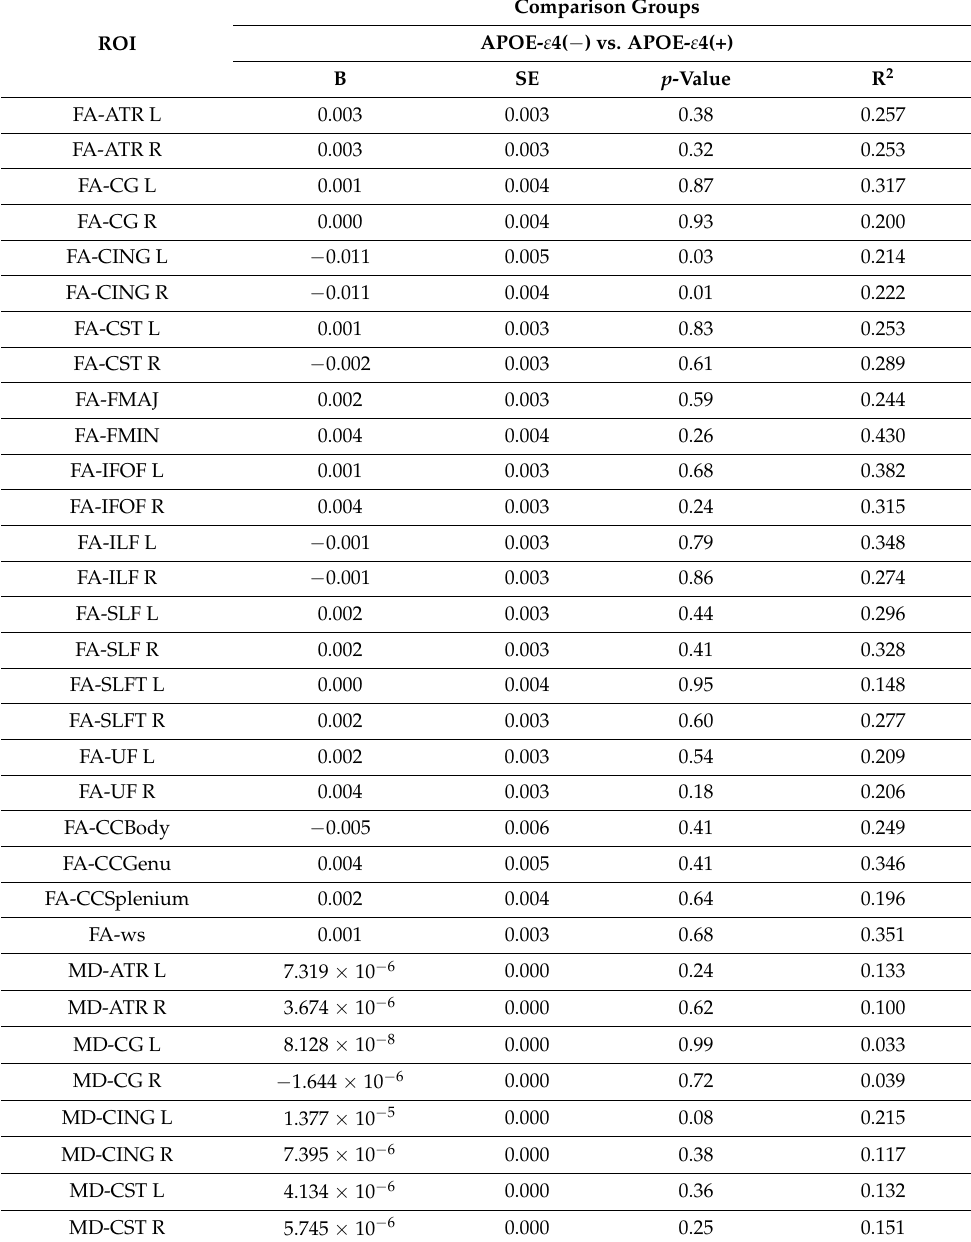
Table 8. Multivariable regression of APOE- ε 4 status and DTI (fractional anisotropy (FA) and mean diffusivity